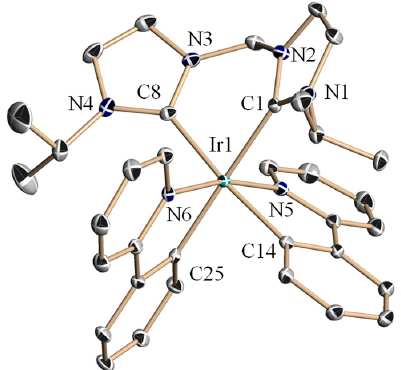
Figure 2. Molecule structure of 4a in the solid state. Hydrogen atoms and non-coordinating anions are omitted for clarity. Selected distances [Å] and angles [°]: Ir-C1 2.120(4), Ir-C8 2.102(4), Ir-C14